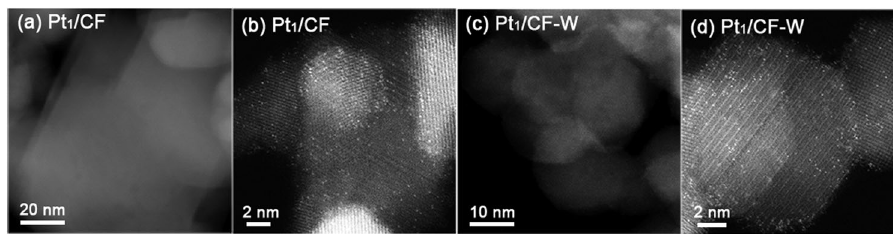
Fig. 1 HAADF-STEM images. a , b Pt 1 /CF, c , d Pt 1